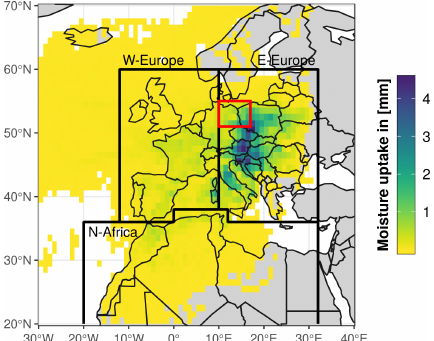
Figure 9. Moisture uptake within the planetary boundary layer, cal- culated based on Lagrangian backward trajectories using ERA5 reanalysis data. Hourly initialised trajectories on 29 June 2017 (00:00 to 23:00UTC) at the region of heavy precipitation (red box) from 1000 to 200hPa in steps of 50hPa and 80km horizontal dis- tances, going back 240h in time, are used to compute moisture up- take based on humidity changes, if they are associated with precip- itation in the target region. Figure 10. Return periods of the 24h precipitation totals based on